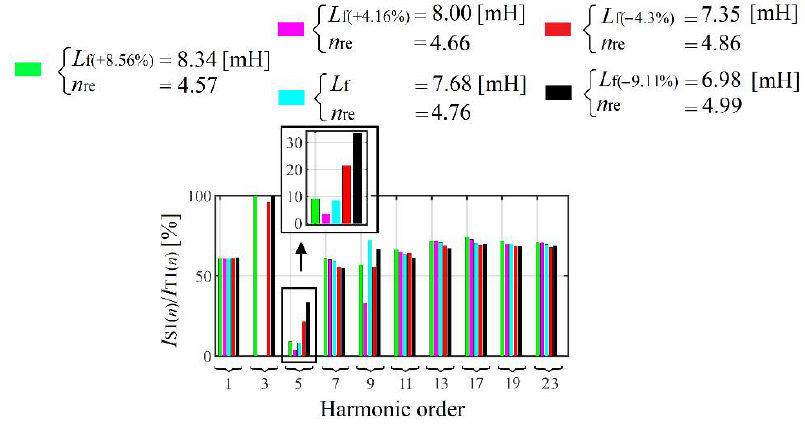
Figure 57. The 5th harmonic reduction efficiency.